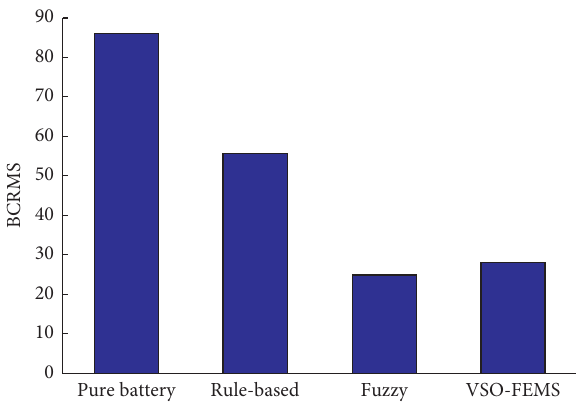
Figure 11: The BCRMS of different